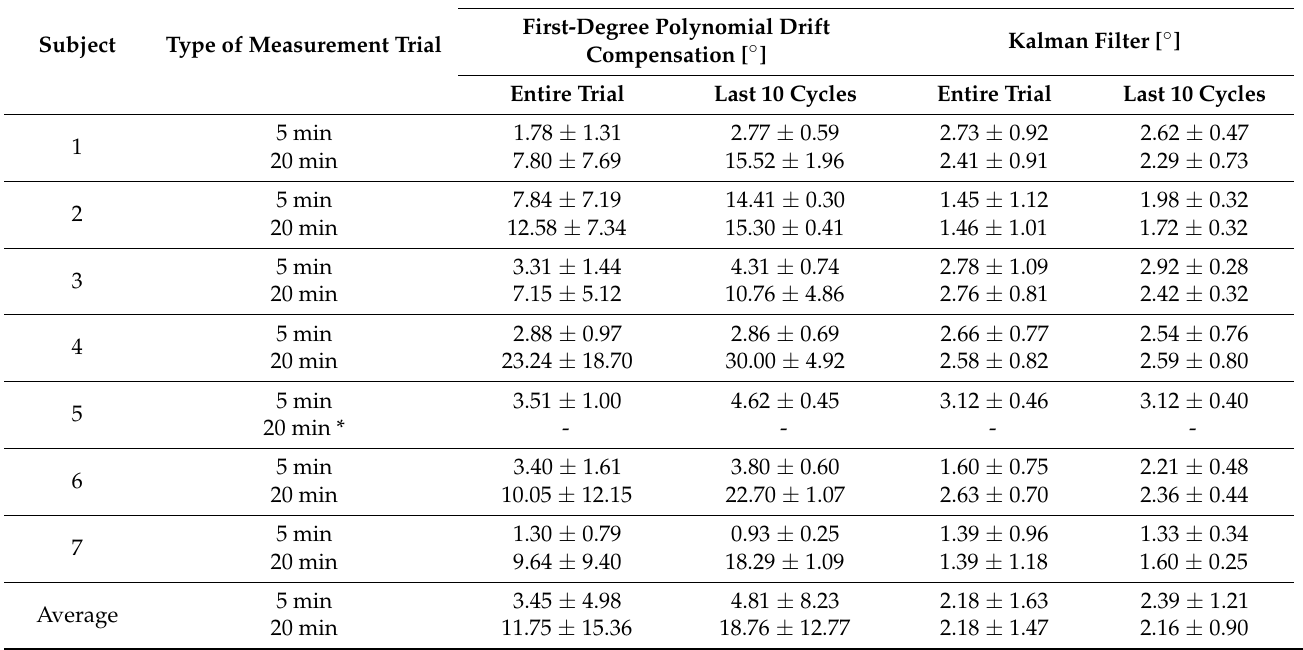
Table 2. Knee joint angle average root mean square errors ( RMSE ) by crank cycle with an interval of ± two standard deviations for the entire measurement trial and the last 10 cycles. The average RMSE for each method is presented at the end of the